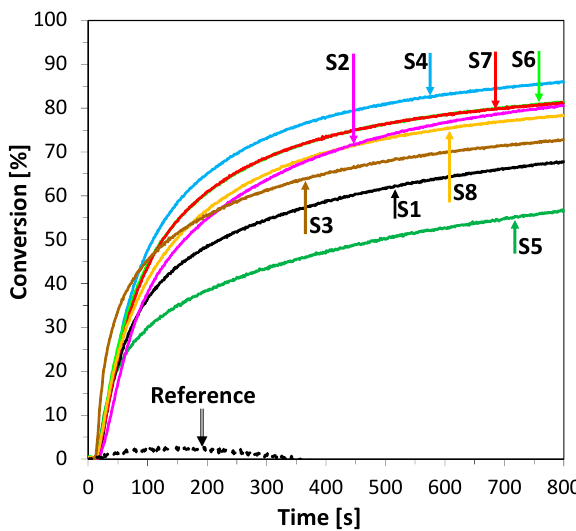
Figure 6. Polymerization profiles of 3,4-epoxycyclohexylmethyl 3,4-epoxycyclohexanecarboxylate (CADE) (epoxy function conversion vs. irradiation time) upon exposure to the UV LED at 365 nm (intensity at the surface of sample 1.59 mW/cm 2 ) under air in the presence of different photoinitiating systems based on diphenyliodonium salt (HIP, wt.%) and 2-amino-4,6-diphenyl-pyridine-3-carbonitrile derivatives (0.1 wt.%). The irradiation starts at t = 10 s.